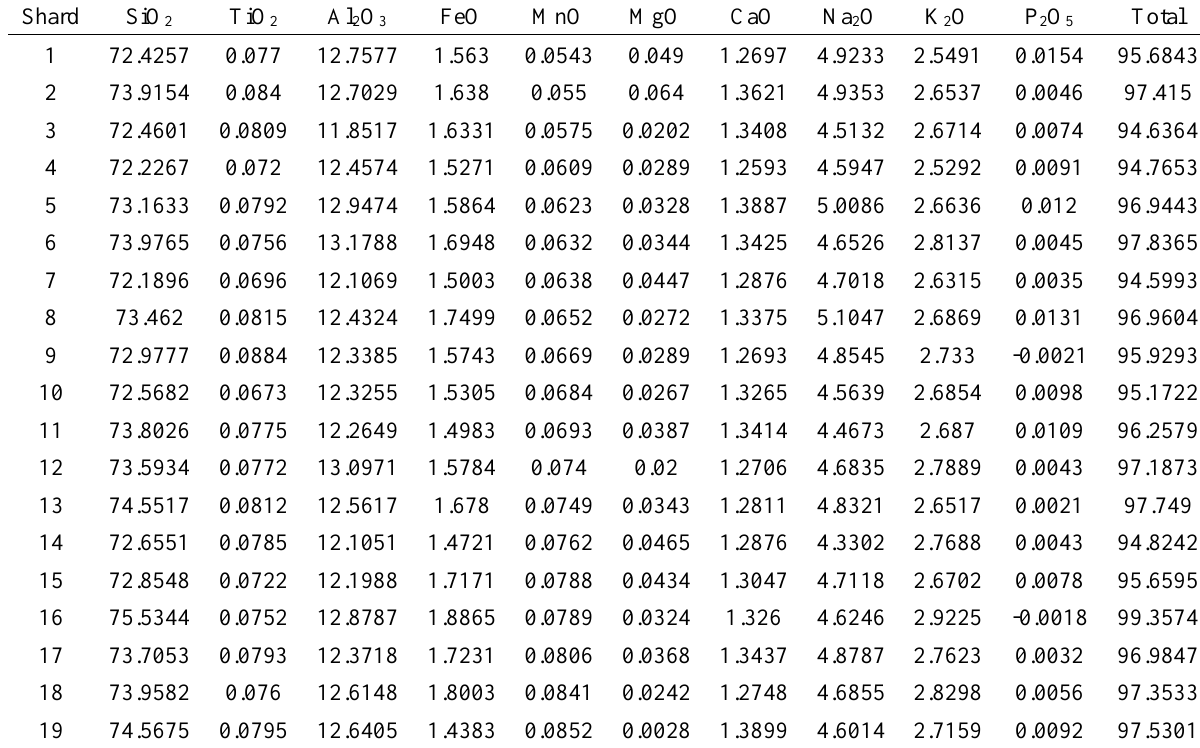
Table A5. Geochemistry from electronmicroprobe analysis of tephra shards found in the Bad a’ Cheo Forest core at 122 cm, identified as Lairg